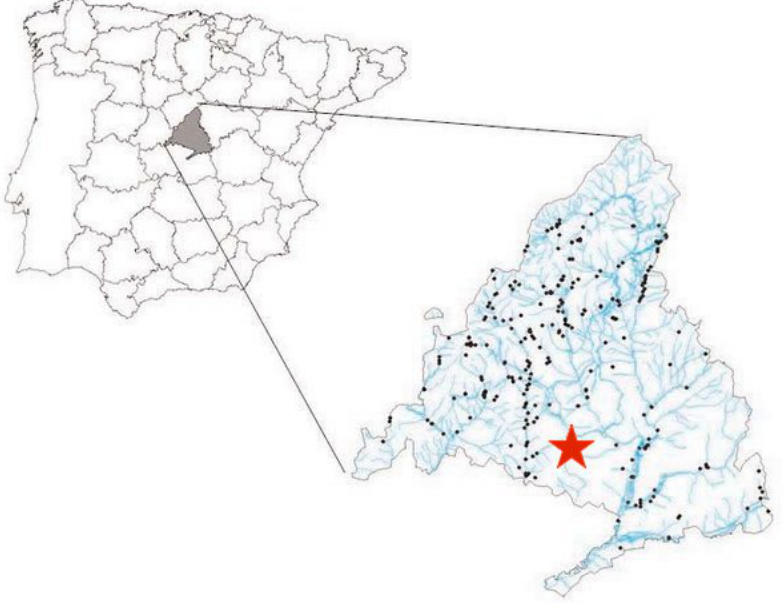
Figure 2. Location of the study object in Spain.